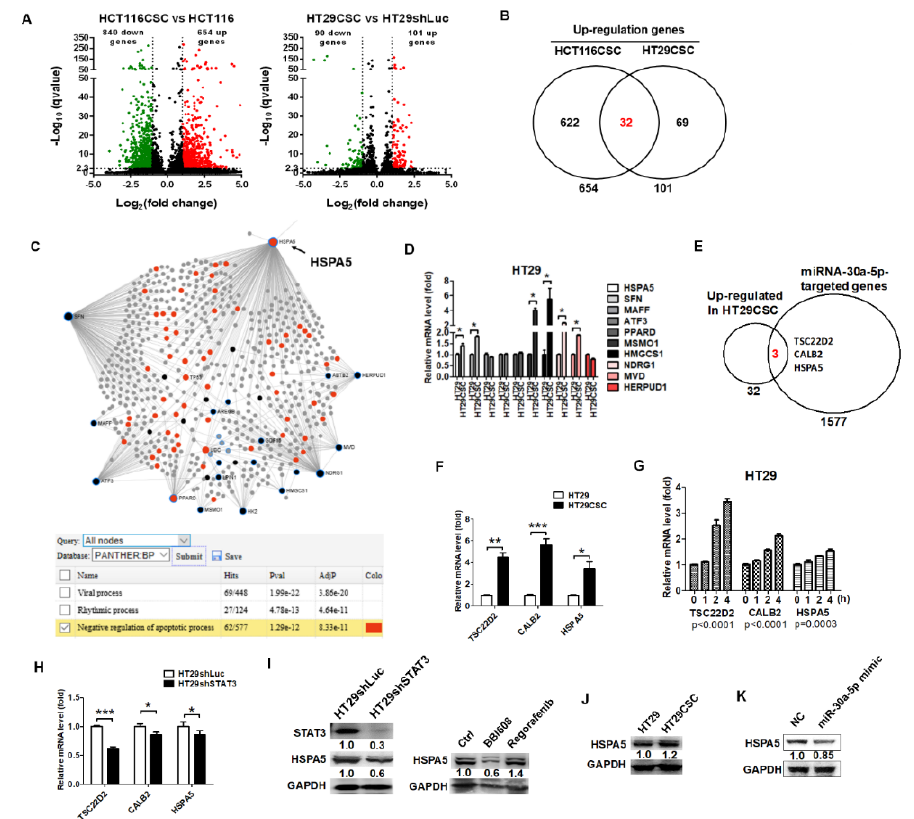
Figure 5. Gene expression profile in HCT116CSC and HT29CSC cells revealed that STAT3-mediated miR30a-5p downregulation increased HSPA5 expression to promote cancer stemness. ( A ) RNAseq data revealed 654 and 101 upregulated genes and 840 and 90 downregulated genes in HCT116CSC and HT29CSC cells, respectively. Among them, ( B ) there were 32 common genes upregulated in